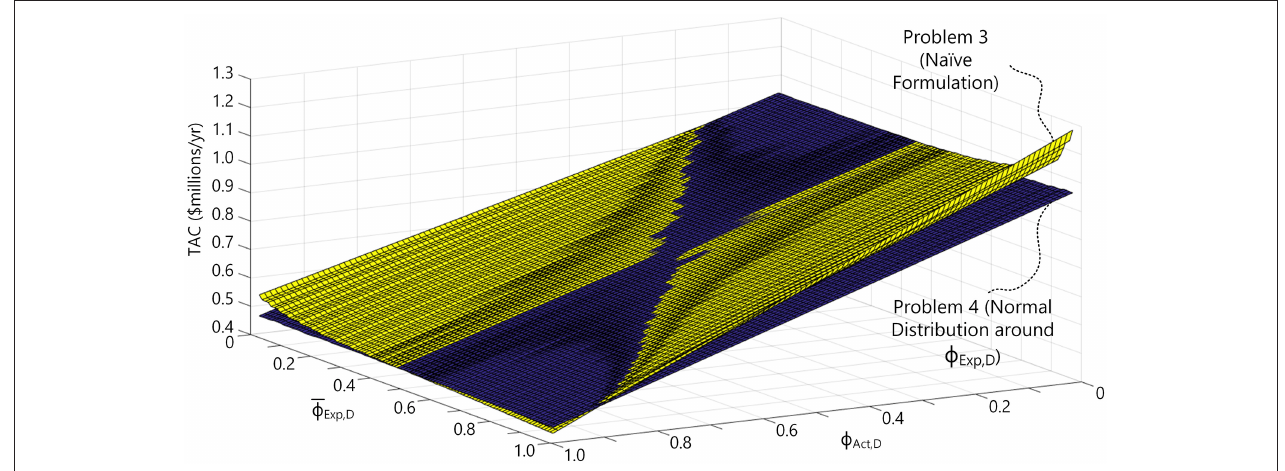
FIGURE 11 | The actual TAC as a function of the mean expected φ Exp , D of the prediction and the actual φ Act , D using the Problem 4 formulation, with the results from the naïve approach from Figure 9 included.